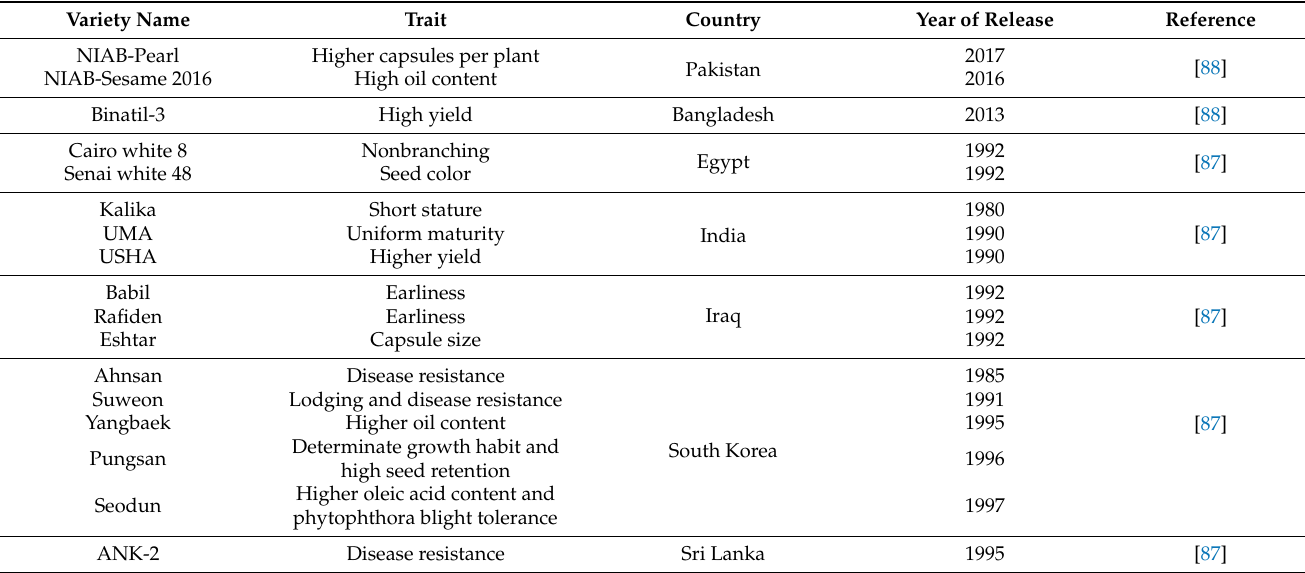
Table 5. Some sesame varieties developed through induced mutation with traits descriptions.